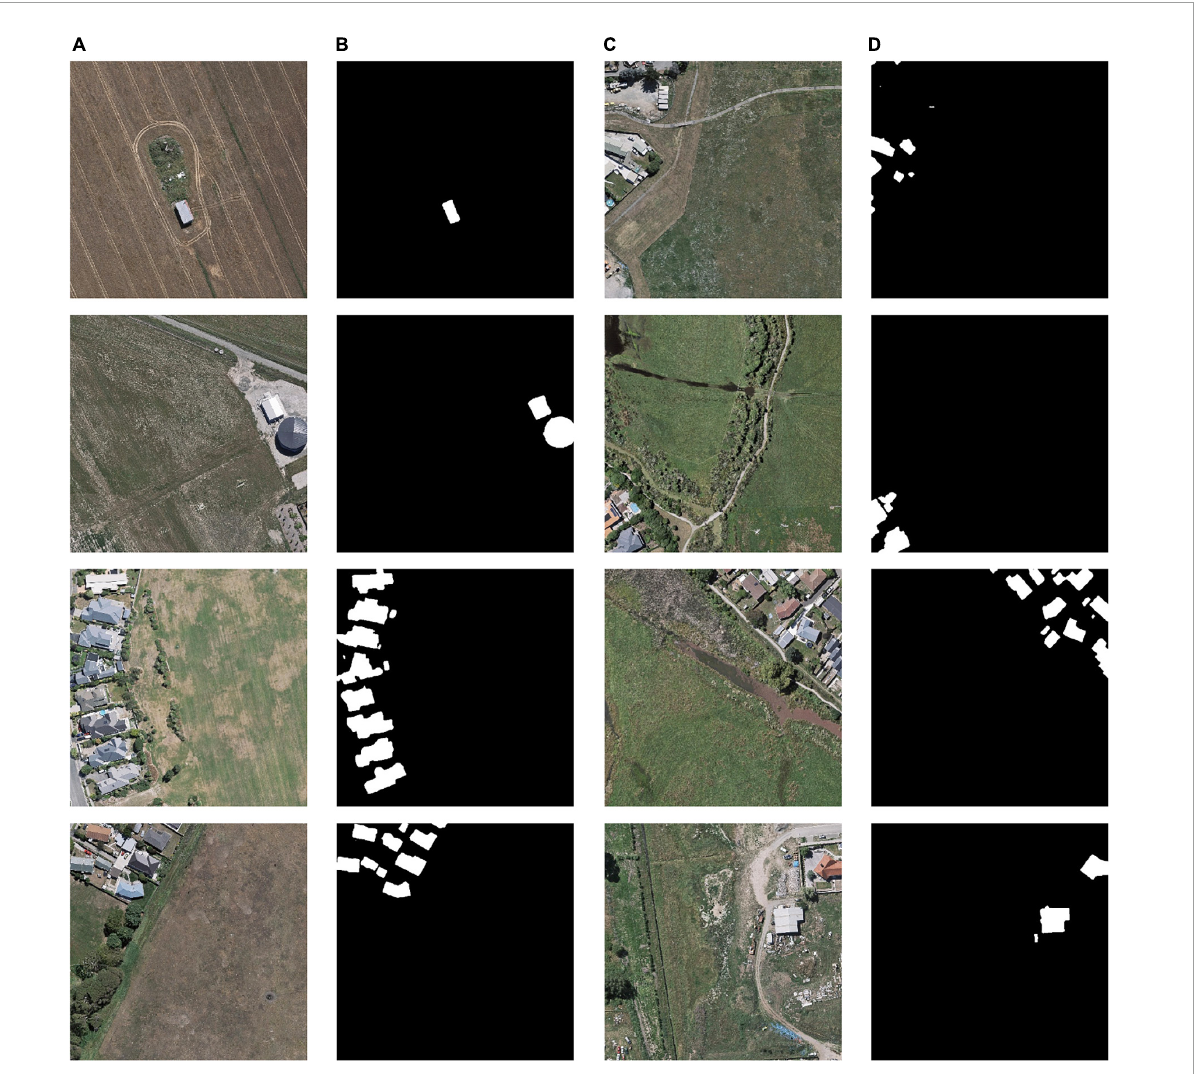
FIGURE11 Building extraction results: (A) original remote sensing image; (B) prediction of AttsegGAN; (C) original remote sensing image; (D) prediction of